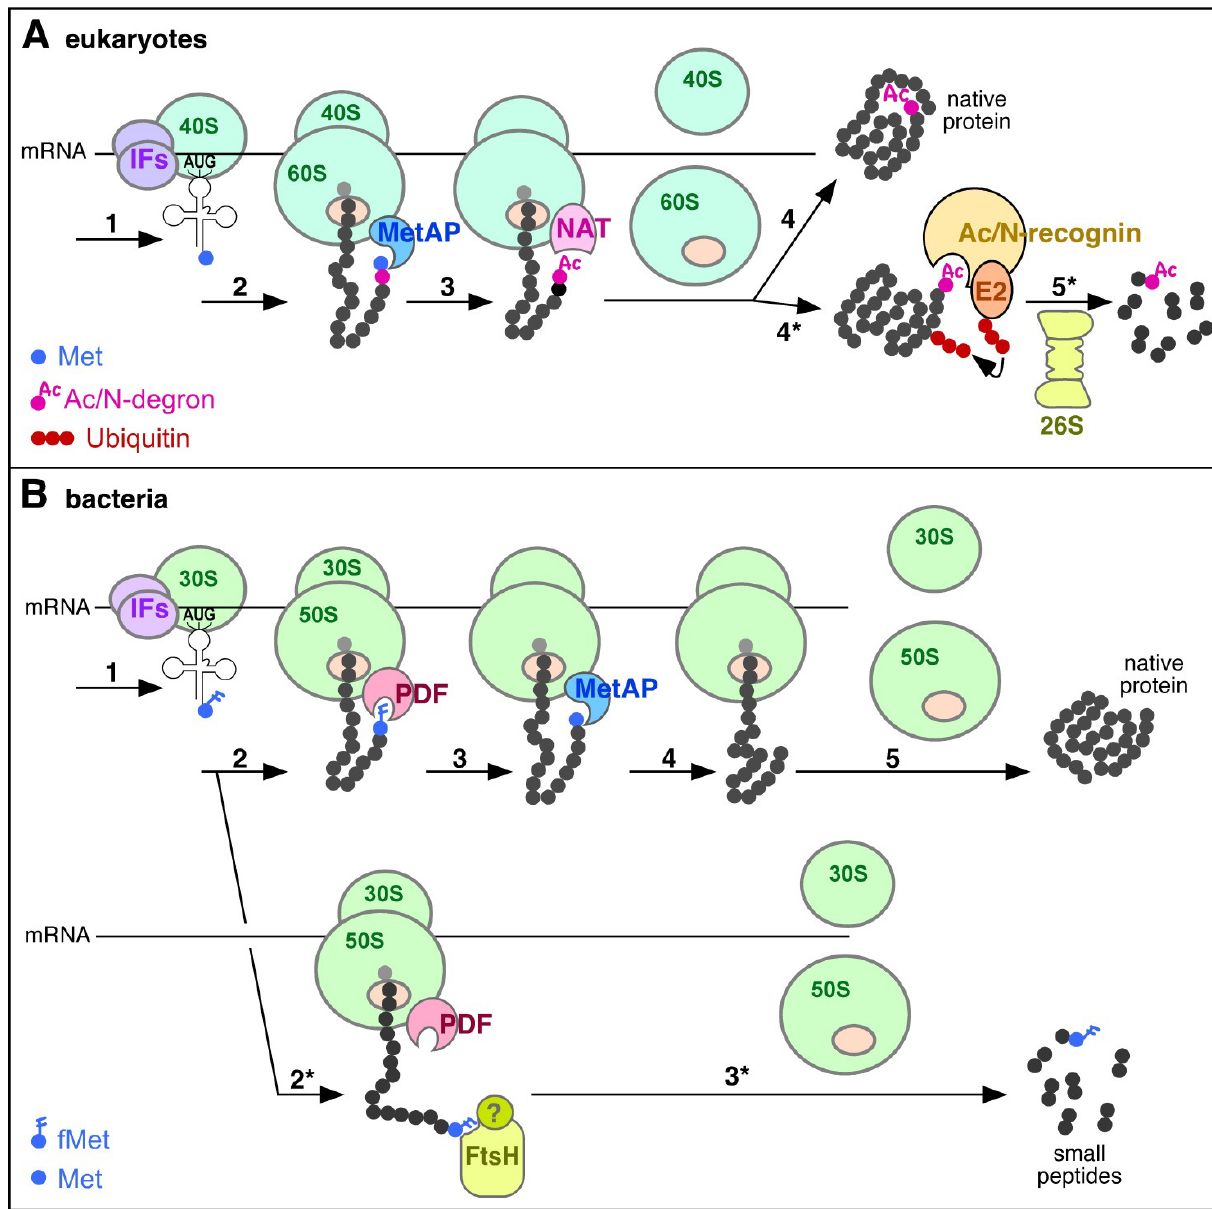
FIGURE 1: Role of N-terminal modifications in proteolytic targeting of nascent proteins. (A) Role of Nt-acetylation in the degradation of nascent proteins in eukaryotes. Step 1, translation initiation by a complex of the small ribosomal subunit ( 40S ), initiation factors ( IFs ) and Met-tRNA; step 2, translation elongation after binding of the large ribosomal subunit ( 60S ); step 3: removal of Met by Met-aminopeptidase ( MetAP ); step 4: N-terminal acetylation of the α-amino group by Nt-acetyltransferase ( NAT ), followed by the completion of translation, and the release of ribosomal subunits as well as of the completed, folded protein, with sterically shielded Nt-acetyl group. Alternatively, in